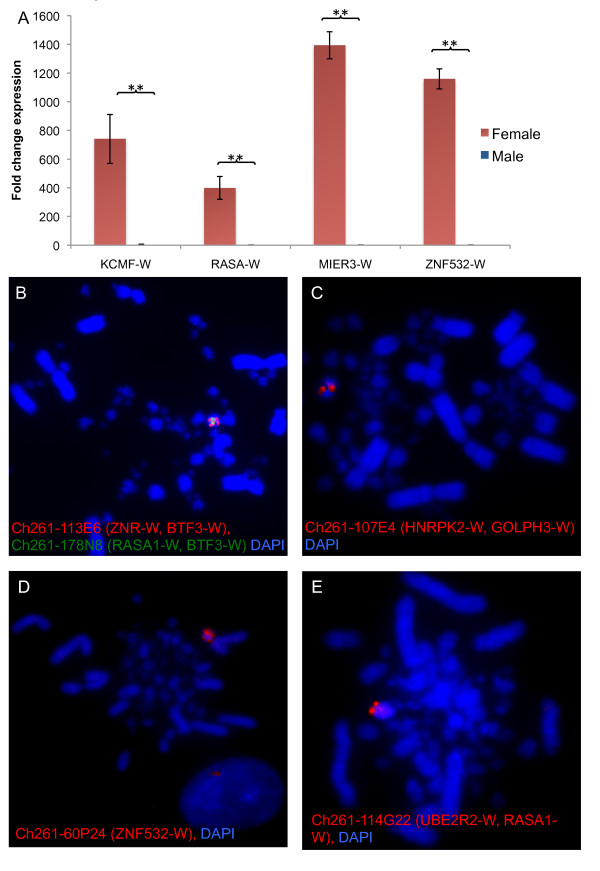
Validation of RNA-seq by quantitative RT-PCR and Confirmation of W-linkage. (A) Blastoderm expression analysis of four representative W genes, KCMF-W, RASA-W, MIER3-W and ZNF532. Expression was detectable in females (red) but not in males (blue). Normalised W gene expression is shown; mean +/- SEM; n = 3; ** P <0.05. (B-E) FISH mapping of genes identified by RNA-seq to the W sex chromosome in female chicken metaphase spreads. BAC clones were used as probes. (B) BAC clone Ch261-113E6 (ZNR-W, BTF3-W) (red) and BAC Ch261-178N8 (RASA1-W, BTF3-W) (green). (C) BAC clone Ch261-107E4 (HNRPK2-W, GOLPH3-W (red). (D) BAC clone Ch261-60P24 (ZNF532-W, SnoR58-W) (red). (E) BAC clone Ch261-114G22 (UBE2R2-W, RASA1-W, SnoR121A-W) (red). Metaphase chromosomes are stained with DAPI (blue). A single signal was detected in each case and only in female cells, confirming W linkage.